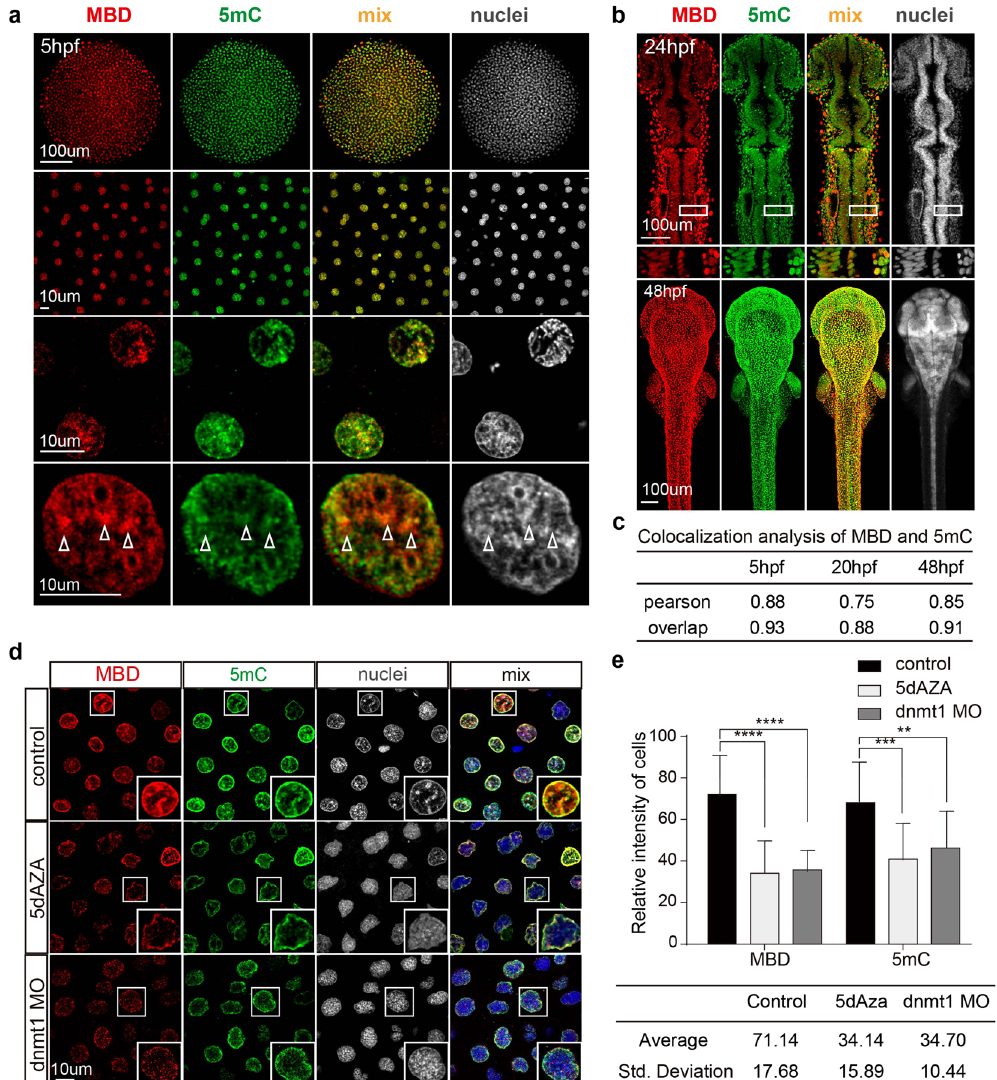
Figure 3. Comparison of the mCherry-MBD and 5 mC distribution patterns. ( a ) The distribution patterns of mCherry-MBD and anti-5 mC staining at 5 hpf. Higher magnification images are arranged below. White arrowheads label compacted puncta of chromatin. ( b ) The distribution patterns of mCherry-MBD and 5 mC at 24 hpf and 48 hpf. White boxes below are magnified 24 hpf images. ( c ) Colocalization analysis between mCherry-MBD, 5 mC, and heterochromatin (N = 12). ( d ) Comparison of nuclei from control embryos, and embryos treated by 5-dAZA or injected with dnmt1 MO. White boxes at right bottom are magnifications of each enclosed cell. ( e ) Fluorescence intensity of cells in each group (N = 16). The intensity value ranged from 0 to 255. P < 0.05. The intensity spectrums represented by the standard deviation are listed